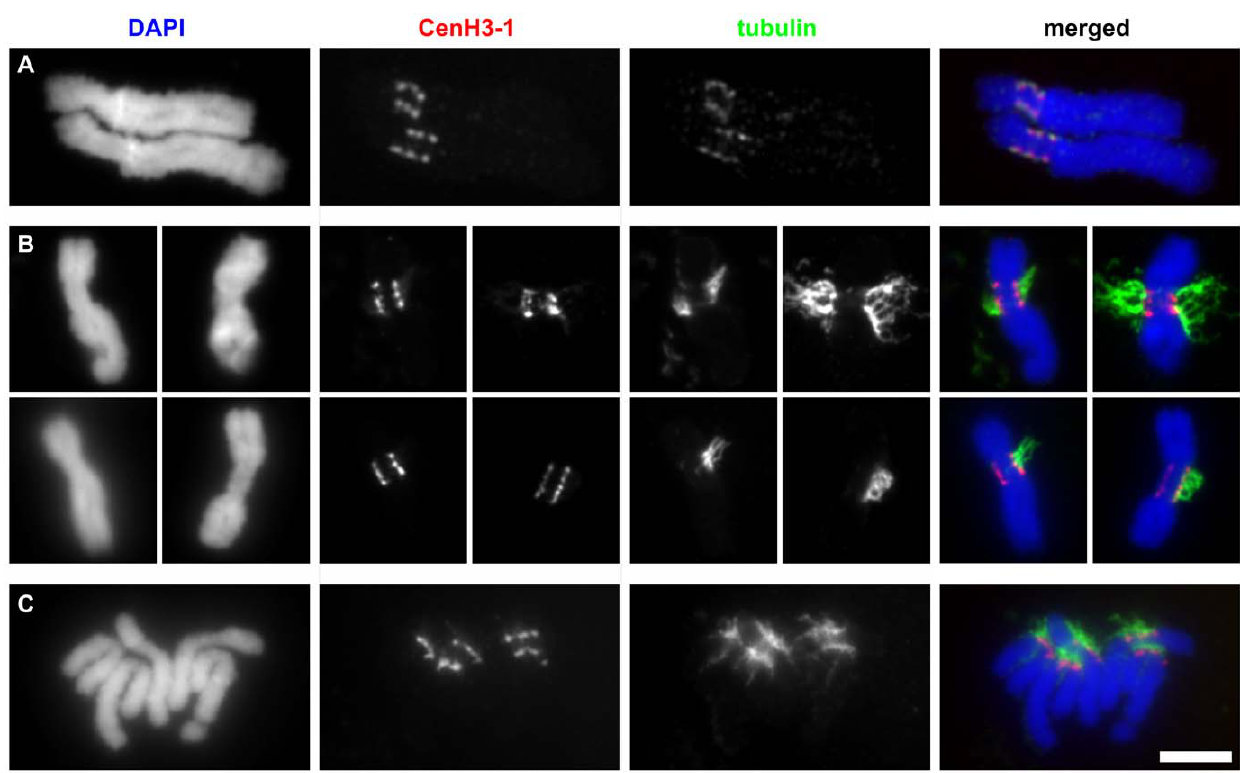
Figure 3. The CenH3-containing domains are fully colocalized with tubulin. A: Immunodetection of tubulin and CenH3-1 on two isolated metaphase chromosomes 3. Although isolated chromosomes never remained attached to microtubules they rarely exhibited weak tubulin signals which fully colocalized with CenH3-1. B–C: Detection of tubulin and CenH3-1 on chromosomes prepared using squash technique. The squash technique allowed some chromosomes to remain attached to microtubules. Whenever present, the remnants of mitotic spindle attached to chromosomes at all CenH3-containing domains on both metaphase (B) and anaphase (C) chromosomes. Bar=5 m m.